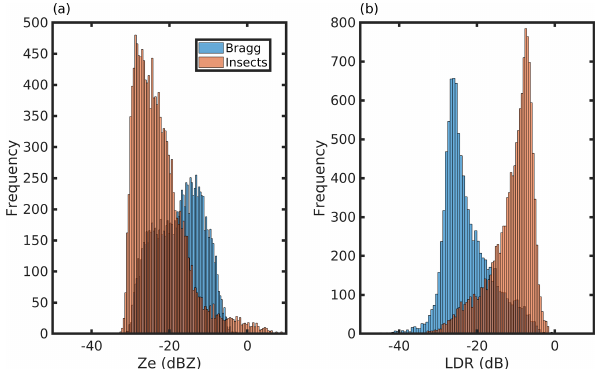
Figure 2. Histograms that show distribution of values of (a) Ze and (b) LDR for Bragg scatter (blue) and insects (red) during 9 May 2018. Bragg scatter and insects can be easier separated with LDR, which shows higher values for insects because of their non- spherical